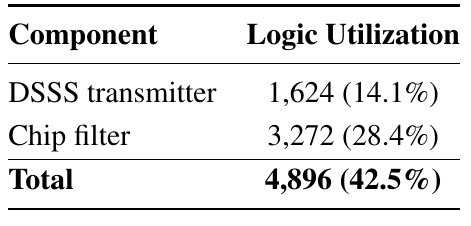
Table 3. FPGA logic resource utilization of the DSSS transmit path.